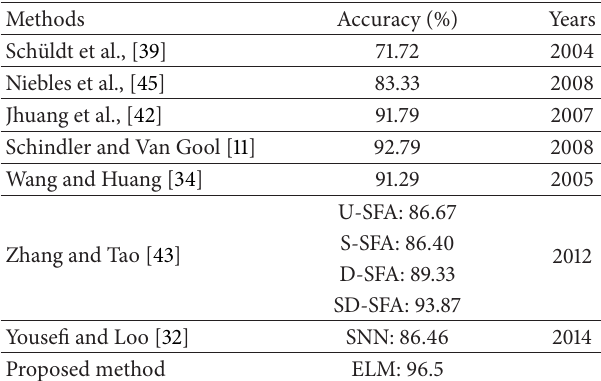
Table 1: The proposed comparison method recognition results revealed among previous human action recognition method accu- racies (bio- or non-bioinspired) on KTH human action